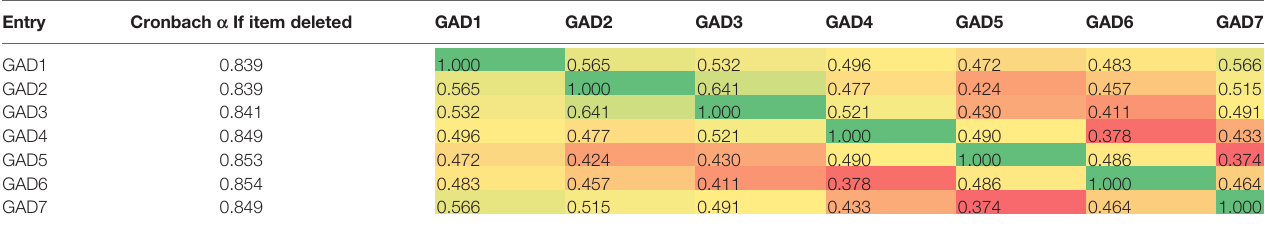
TABLE 2 | Cronbach a and correlation coef fi cient of different items on the GAD-7 scale.